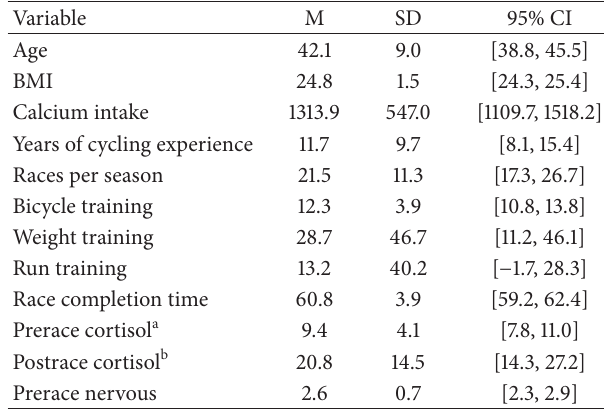
Table 1: Means, standard deviations, and 95% confidence intervals for cyclist characteristics.